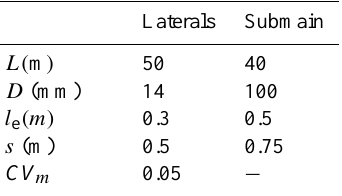
Table 1. Proportion of sand, silt, and clay in the soils as determined by the Bouyoucos densimetry method.